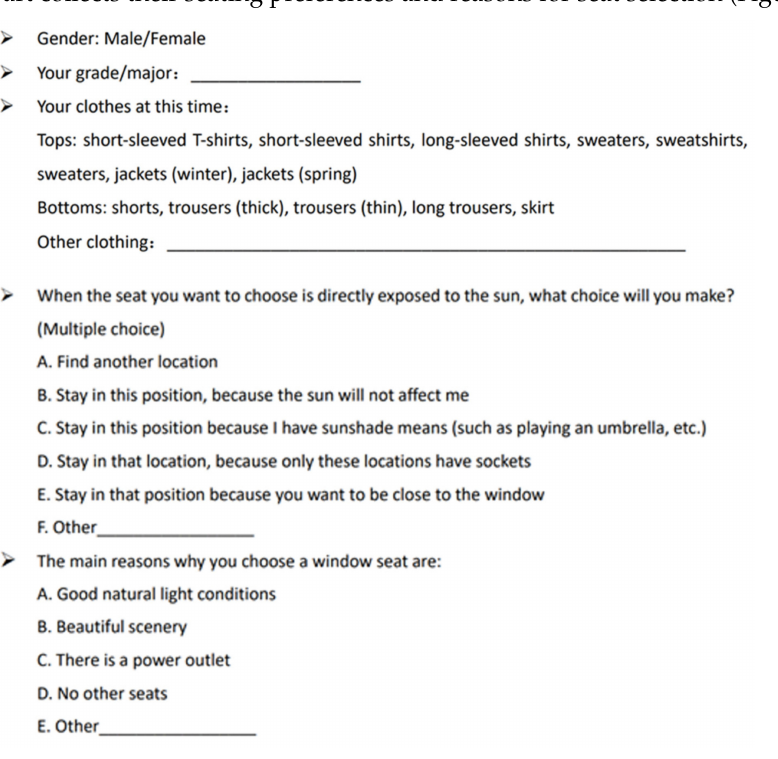
Figure 6. Part of